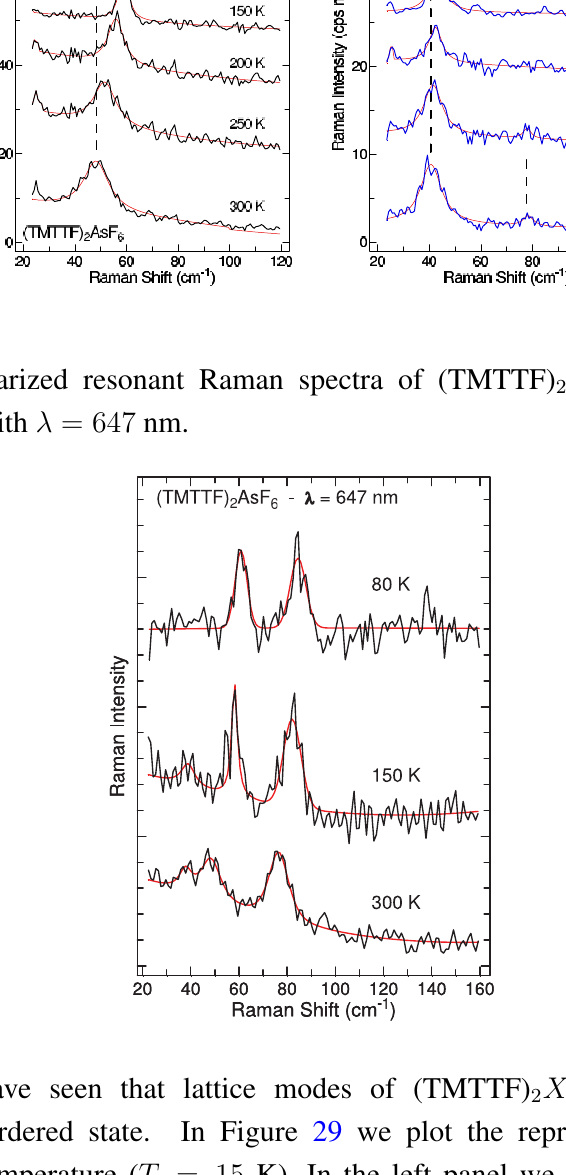
Figure 27. Low-frequency Raman spectra of (TMTTF) ( b (cid:48) , a ) obtained at different temperatures using the λ = 752 nm laser line. Note the different intensity scale: B spectra are two times weaker than A g